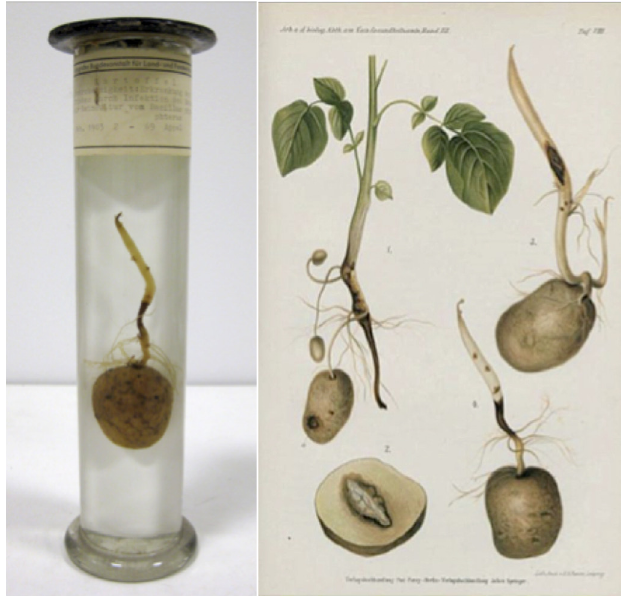
Fig. 1: Blackleg disease on potato. Left: sprouting potato with symptoms of blackleg disease after cultivation in infected soil, specimen col- lected by Otto Appel and preserved in formalin (Phytopathological Collection of the Julius Kühn Institute; image by Manfred Gräfe und Djavad Taghizadhe, Stadtmuseum Berlin). Right: illustration in the pocket atlas of potato diseases, drawn by August Dressel ( A ppel , 1926).